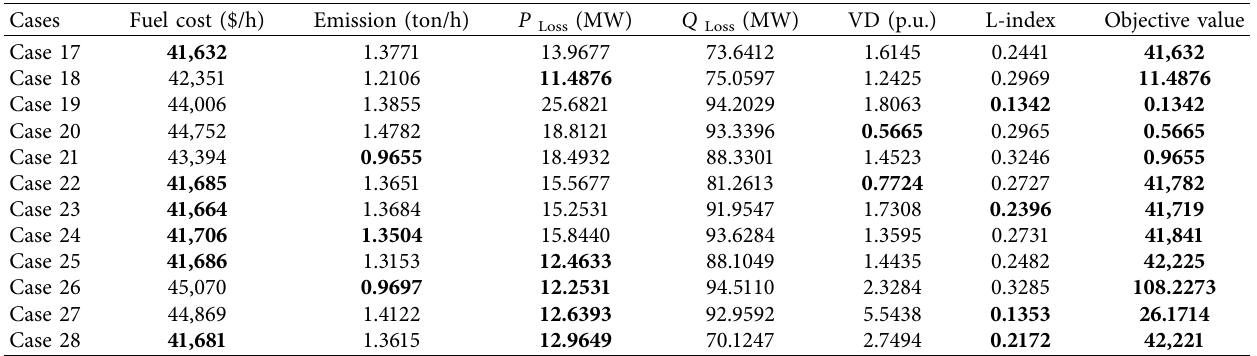
Table 9: Optimal solutions obtained by BSOA for all cases (Case 17 to Case 28) of the IEEE 57-bus system. Cases